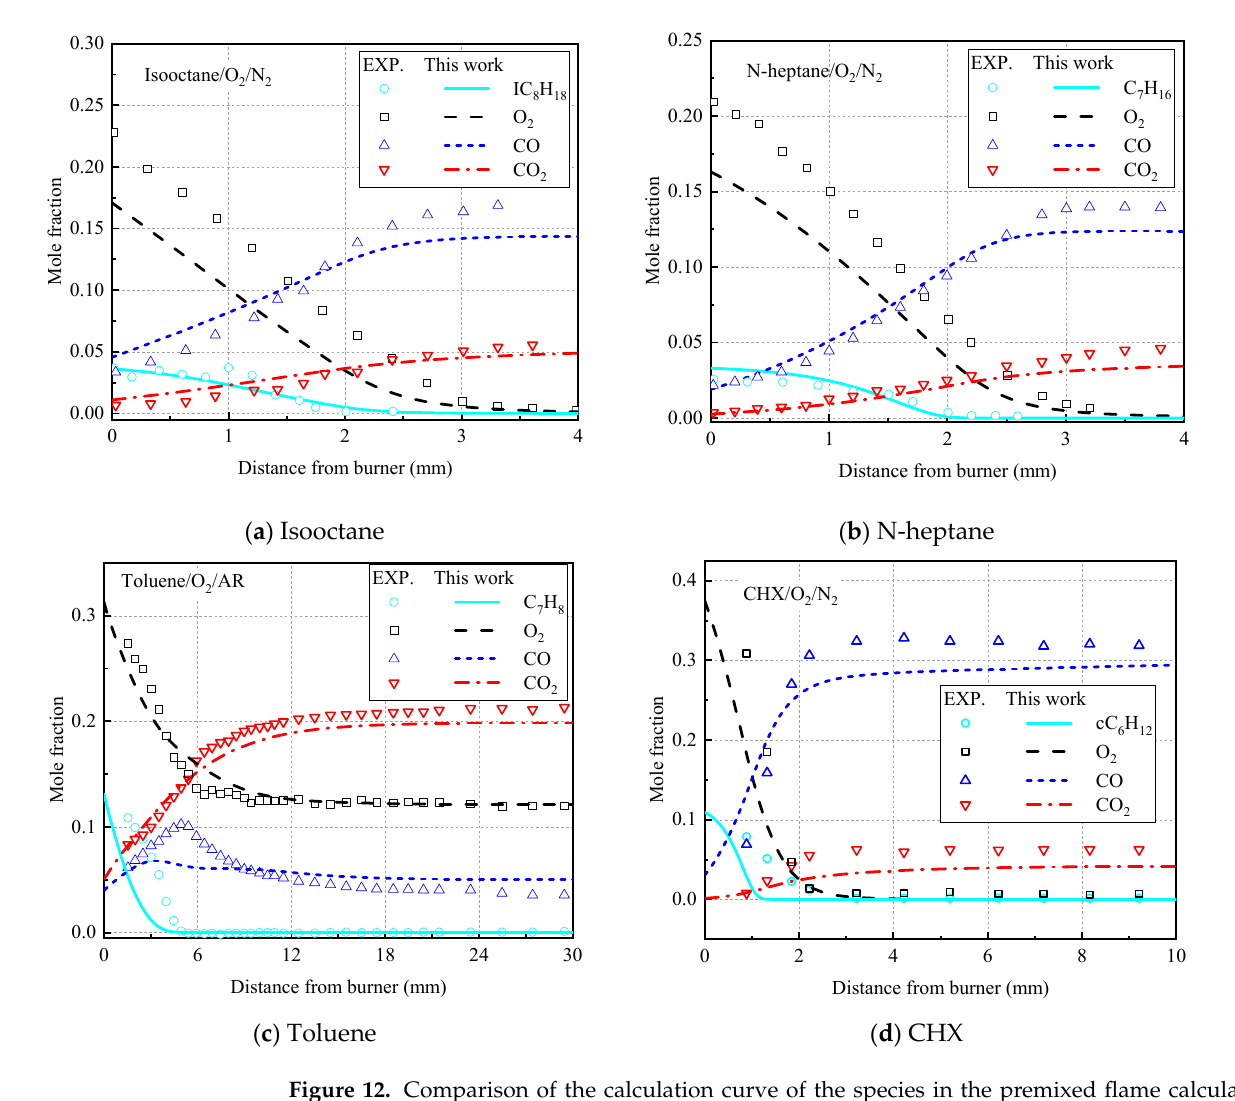
Figure 12. Comparison of the calculation curve of the species in the premixed flame calculated by the experiment [44–46] and the model in this study. ( a ) Isooctane, ( b ) N-heptane, ( c ) toluene, and ( d ) CHX .